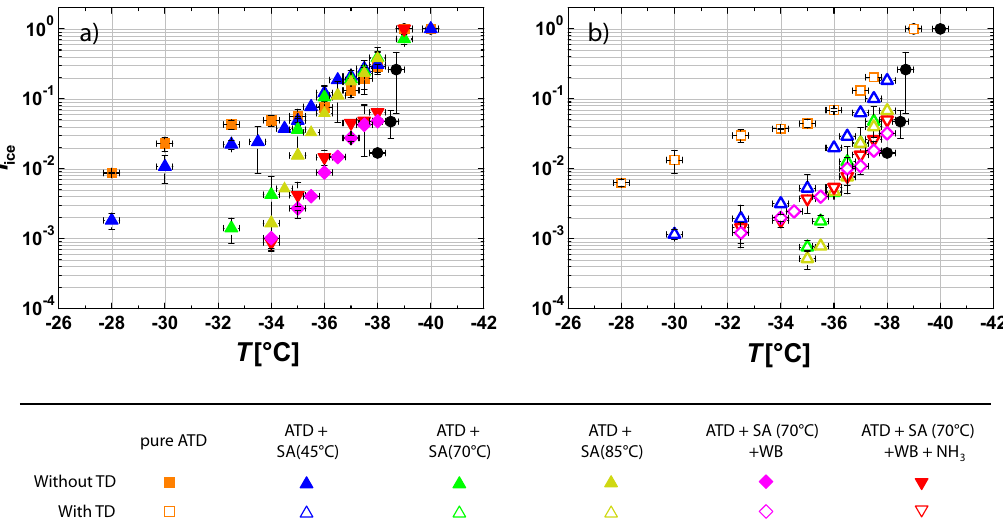
Fig. 3. Immersion freezing behavior of all types of examined particles. Panel (a) shows ice fractions f ice of pure and coated ATD par- ticles (filled symbols). Panel (b) shows f ice of the thermally treated pure and coated ATD particles using a thermodenuder operating at 250 ◦ C (open symbols). Different colors indicate different particle types/treatments: pure ATD (orange squares), ATD + SA(45 ◦ C) (blue triangles), ATD + SA(70 ◦ C) (green triangles), ATD + SA(85 ◦ C) (dark yellow triangles), ATD + SA(70 ◦ C) + WB (pink diamonds) and ATD + SA(70 ◦ C) + WB + NH 3 (upside down red triangles). Additionally, results for homogeneous freezing of highly diluted ammonium sulfate droplets are shown (black